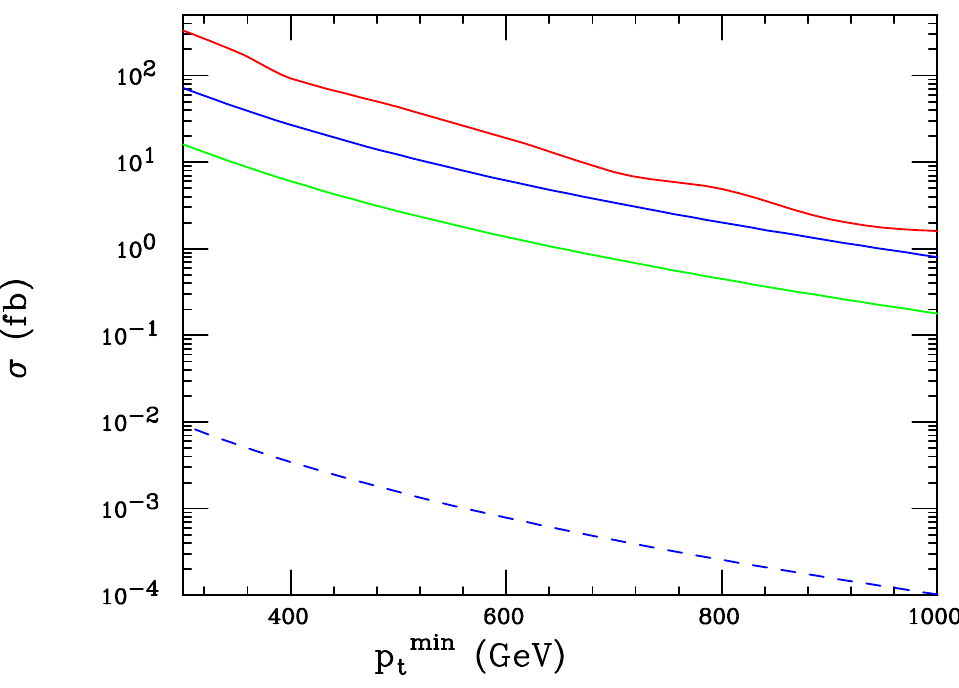
Figure 8 . Comparison of the 13 TeV ATLAS ‘monojet’ cross section upper limit as a function of the leading jet minimum p T (top red curve) with the predictions of several 5-D scenarios assuming that (cid:15) 1 = 10 (cid:0) 4 . The solid blue (green) curve is the prediction assuming R (cid:0) 1 = 100(200) MeV without any BLKTs. The lower blue dashed curve shows the resulting shift in the case of R (cid:0) 1 = 100 MeV case when (cid:14) A = 0 : 5 is